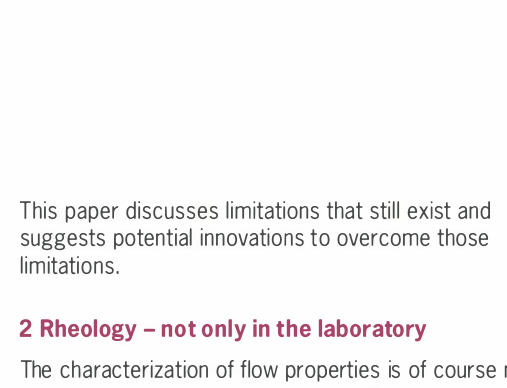
Fig. I: Schematic of types of rheometrical